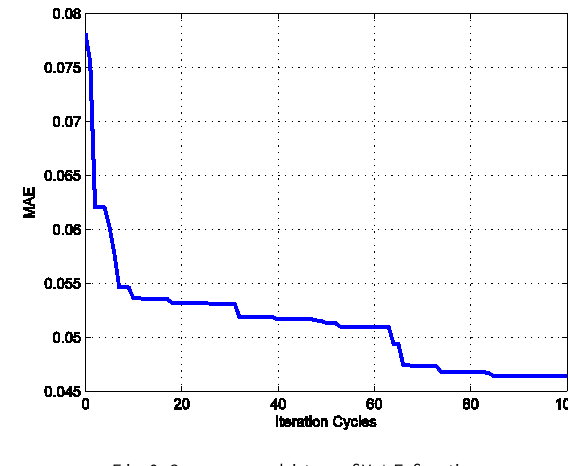
Fig. 9. Convergence history of MAE function.